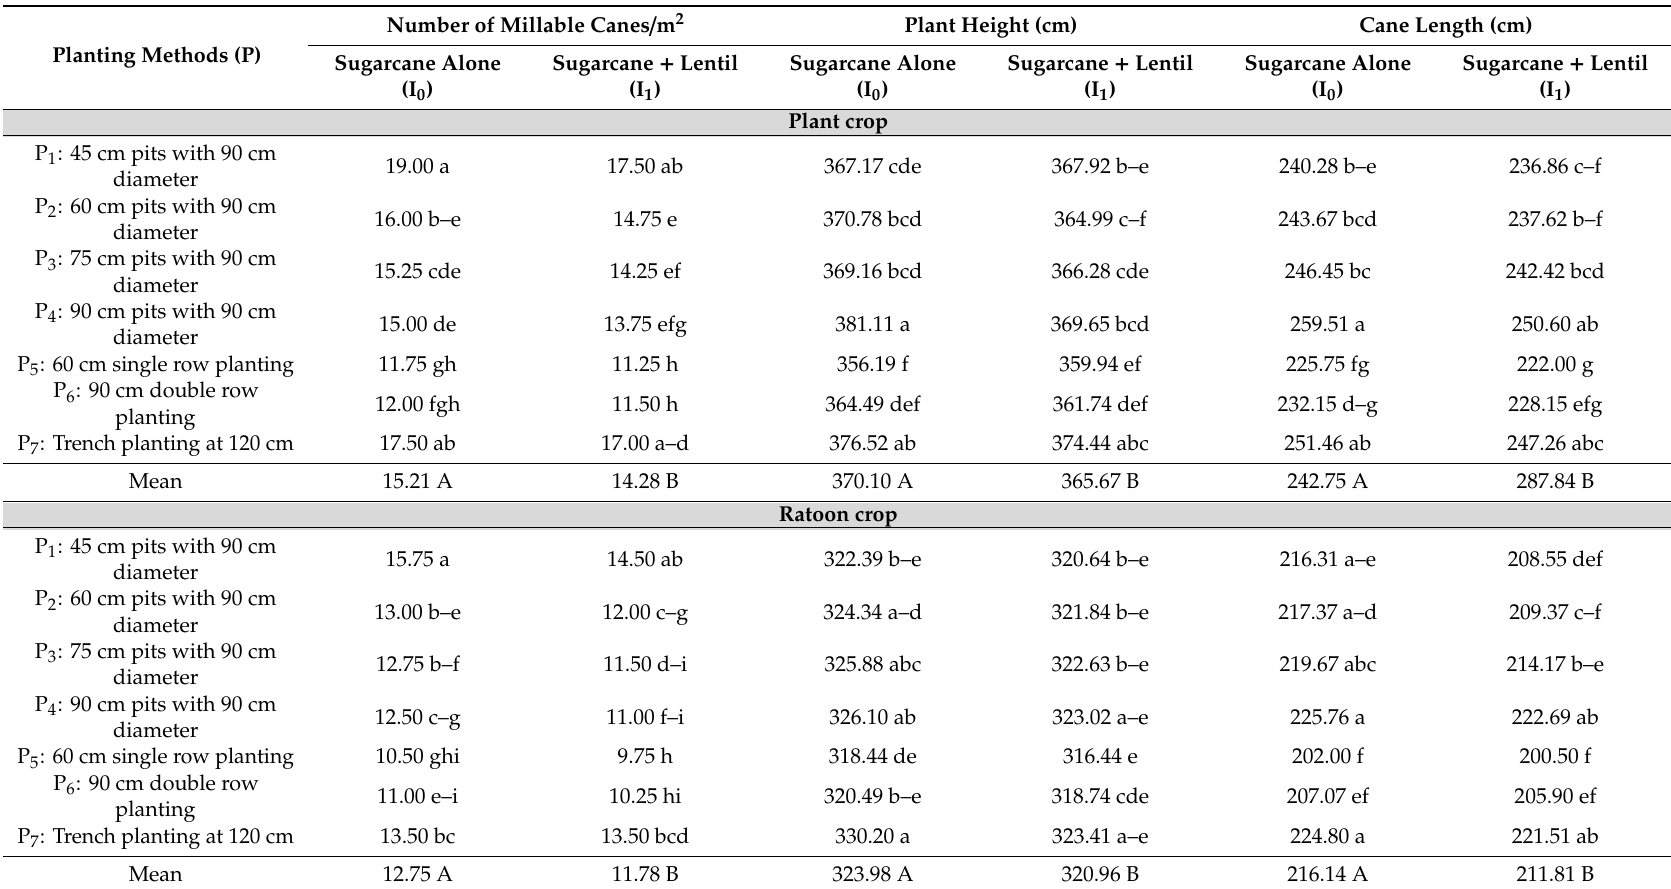
Table 2. Yield contributing traits of sugarcane under di ff erent planting patterns with lentil